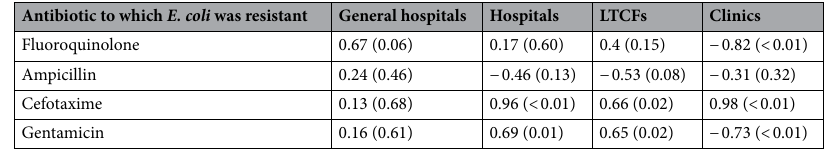
Table 3. Correlation analysis of antibiotic prescription and resistance in Escherichia coli by the institutions between 2007 and 2018. Each value in the cell indicates the coefficient and p -value. LTCFs long-term care